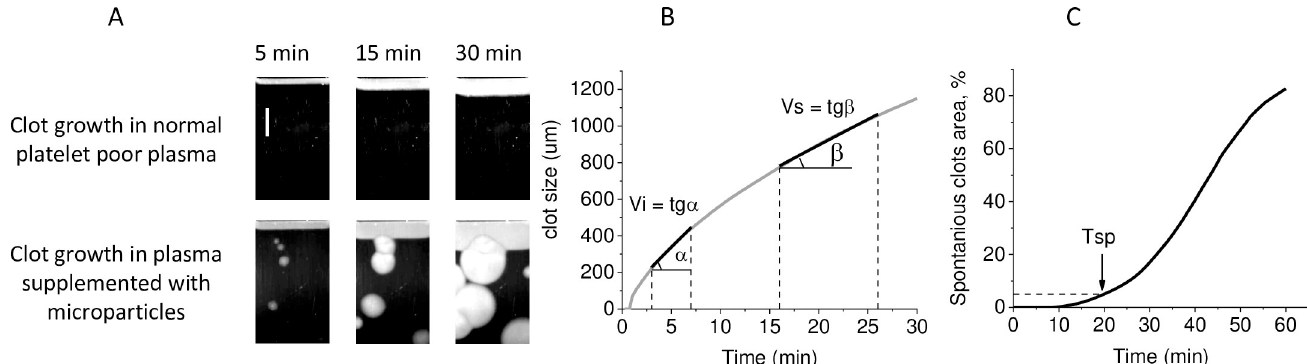
Fig 1. Design of the Thrombodynamics assay. A. Typical images of growing fibrin clot in normal platelet-free plasma and in plasma supplemented with microparticles. Coagulation is activated by immobilized TF (on the top), and the fibrin clot grows into the bulk of the plasma. When plasma is supplemented with microparticles, spontaneous clots in the bulk of the plasma appear. The scale bar is 2 mm. B. Clot size dependence on time, definition of initial clot growth rate, Vi, and stationary clot growth rate, Vs. C. Dependence on time of the percentage of spontaneous clot area of the whole chamber area excluding walls and clot grown from activator (Tsp